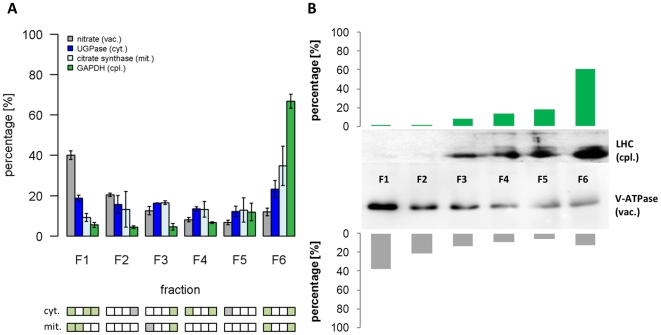
Distribution of compartment-specific markers in non-aqueous gradients from Arabidopsis thaliana leaves.(A) The distribution of vacuolar (nitrate), cytosolic (UGPase), mitochondrial (citrate synthase), and plastidic (GAPDH) markers are shown as the average of three independent gradients. The mean values and standard deviations of marker enzyme activities (UGPase, citrate synthase, GAPDH) or relative concentrations (nitrate) in each fraction are depicted as percentage from total (scaled data). Significant differences (P
BH<0.05, Benjamini-Hochberg corrected) using t-test within each fraction compared to the cytosolic (cyt.) or mitochondrial (mit.) marker are shown as green colored boxes below the graph. Grey boxes illustrate uncorrected significant (P<0.05) differences. (B) Western blots detecting LHC (plastidic) and vacuolar H+-ATPase (vacuolar) membrane proteins in each fraction are shown for one representative gradient to confirm the distribution of the plastidic and vacuolar compartment throughout the gradients. The pixel intensities quantified using ImageJ (http://rsb.info.nih.gov/ij) are drawn as bar diagrams.